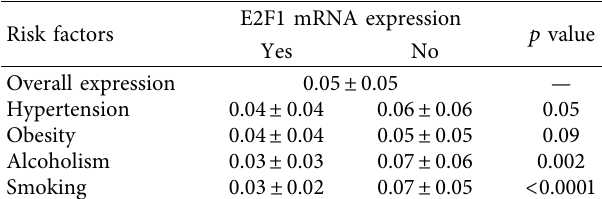
Figure 1: Correlation of microRNA-330 and E2F1 mRNA ex- pression among T2DM cases.